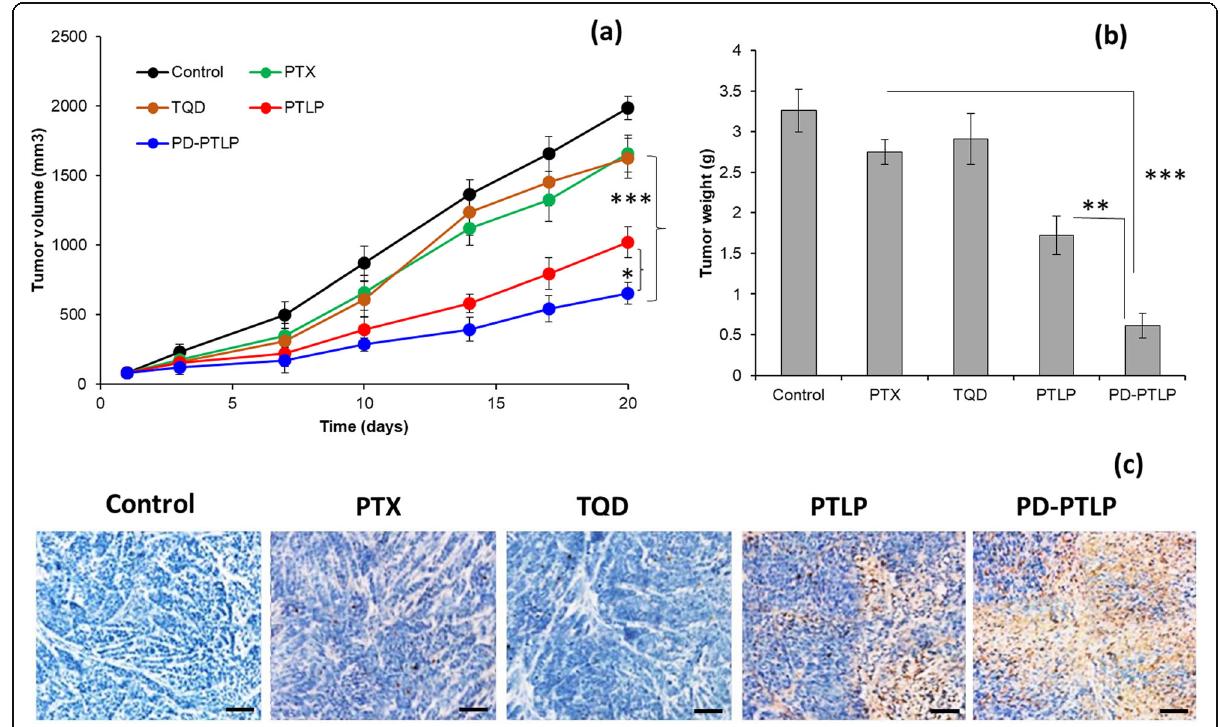
Fig. 6 In vivo antitumor efficacy of different formulations against multidrug resistant (MDR) SGC7901/ADR tumors; a tumor volume, b tumor weight analysis, and c TUNEL assay of tumor tissues. The mice were administered with a fixed dose of 5 mg/kg with duration of three times for three administrations. Apoptotic cells wells were evaluated by TUNEL assay. * p < 0.05 and ** p < 0.05 (PTLP vs. PD-PTLP), *** p < 0.001 (PTX vs. PD-PTLP)-treated